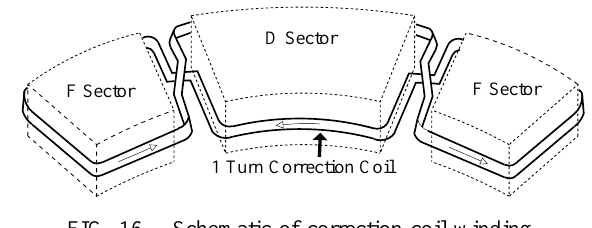
FIG. 16. Schematic of correction coil